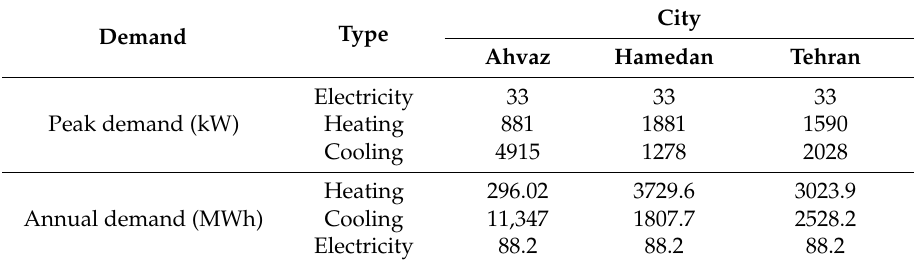
Table 2. Peak demand and annual aggregated power, heating, and cooling demand of the building [36].